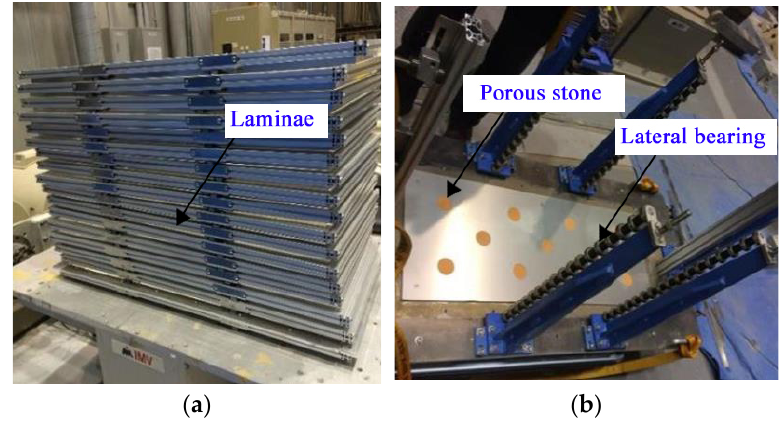
Figure 10. ( a ) Laminae ( b ) skeleton for laminae (From [20]; modified).